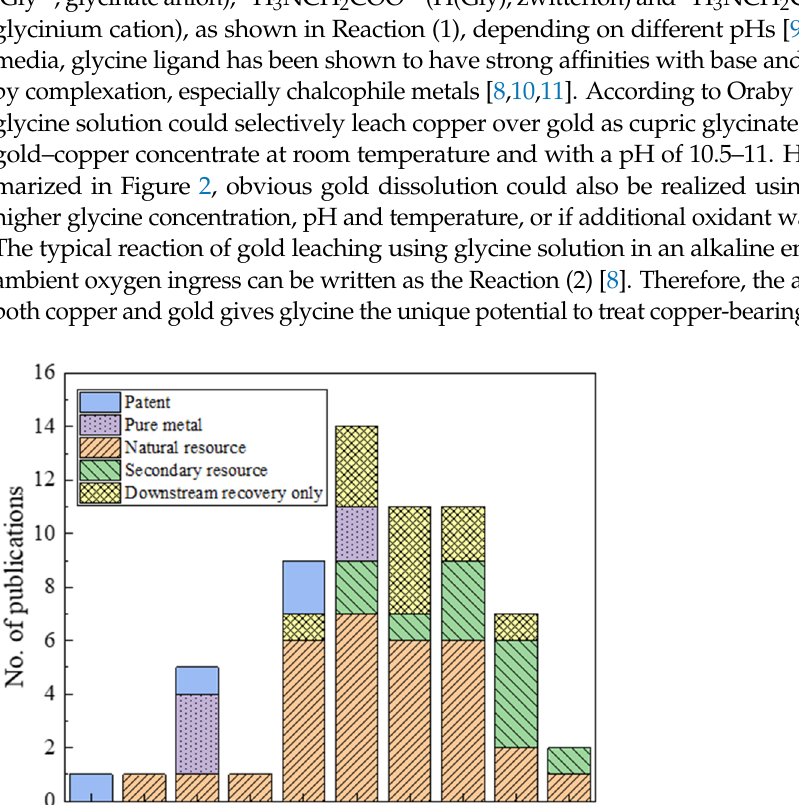
Figure 1. Number of publications regarding glycine leaching systems used to treat different solid resources since 2013 (data for 2022 is up to March 2022).